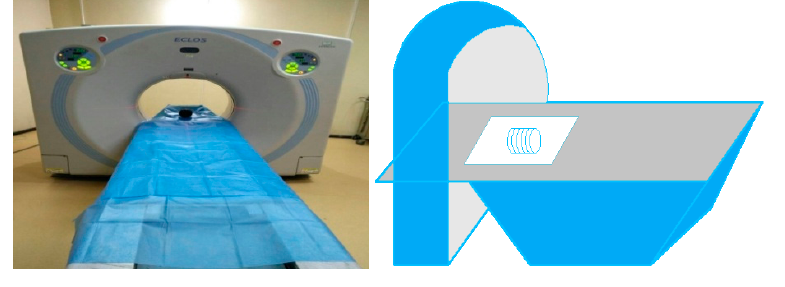
Figure 1. CT test stand. Table 5. CT Scanning Parameters.